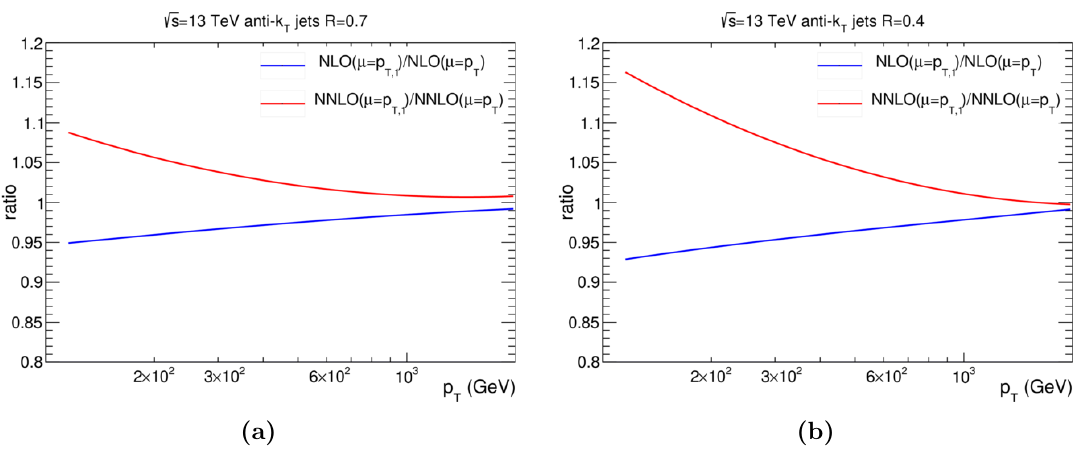
Figure 5 . Perturbative corrections to the single jet inclusive distribution at 13 TeV (CMS cuts, j y j < 4 : 7, R = 0 : 4), integrated over rapidity and normalised to lower order predictions. Central scale choice: (a) (cid:22) = p T ; 1 and (b) (cid:22) = p T .